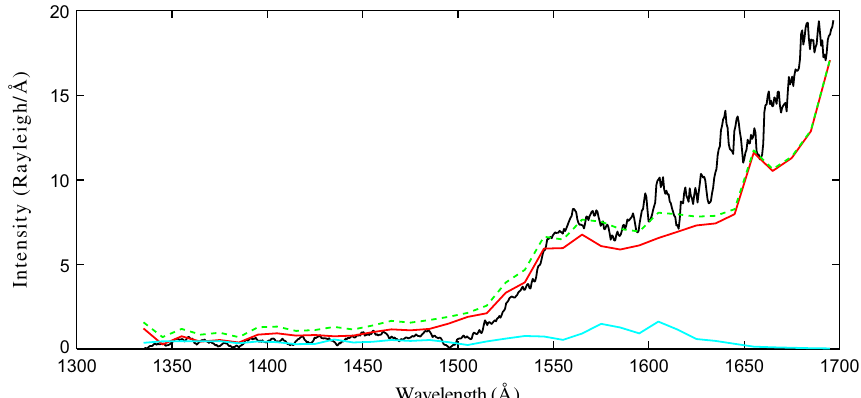
Fig. 6. Different contributions of the HST spectrum of Uranus, recorded November 29, 2011. The black line is the HST spectrum, the blue line is the modeled H 2 spectrum, the red line represents the reflected spectrum, and the green asterisks are the sum of the two previous components. Figure adapted from Barthélemy et al.